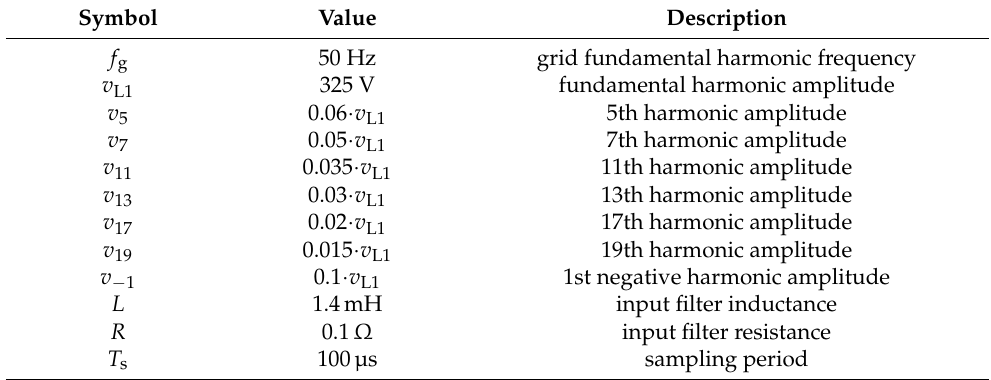
Table 1. Harmonics amplitudes and converter parameters used during the optimization process.